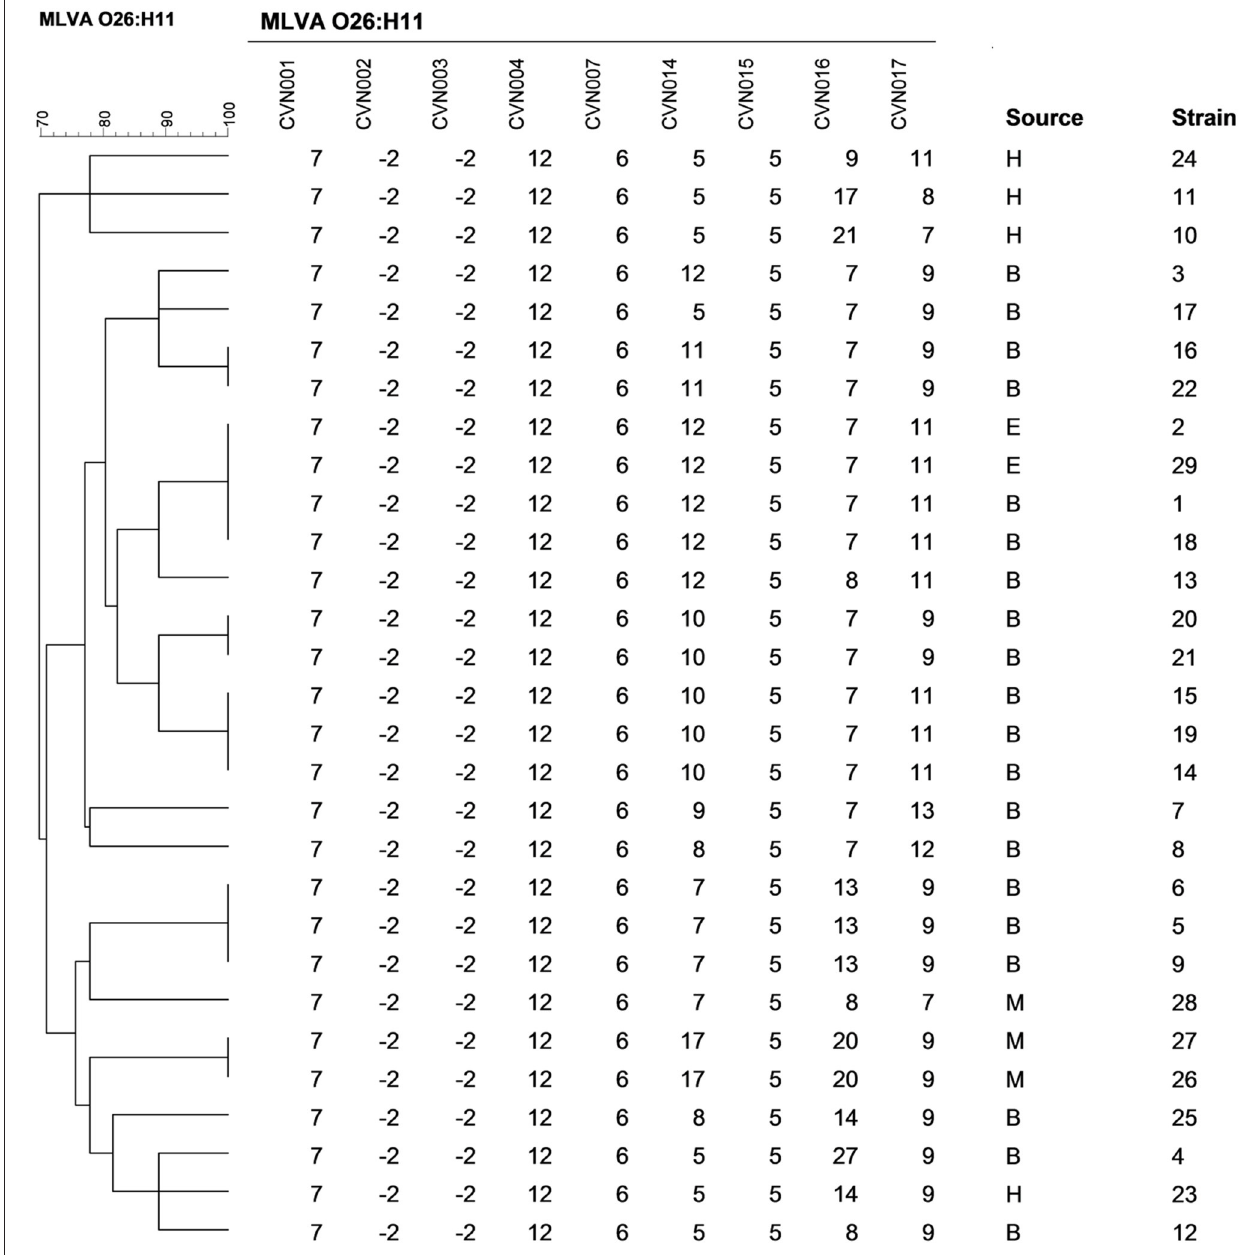
FIGURE 2 | Multiple-locus variable-number tandem repeat analysis–based clustering of STEC O26:H11 isolates investigated in this study. Similarities among MLVA profiles were calculated using categorical coefficients and UPGMA clustering method. B, E, H, andM indicate isolates obtained from bovine, environmental, human, and meat sources,